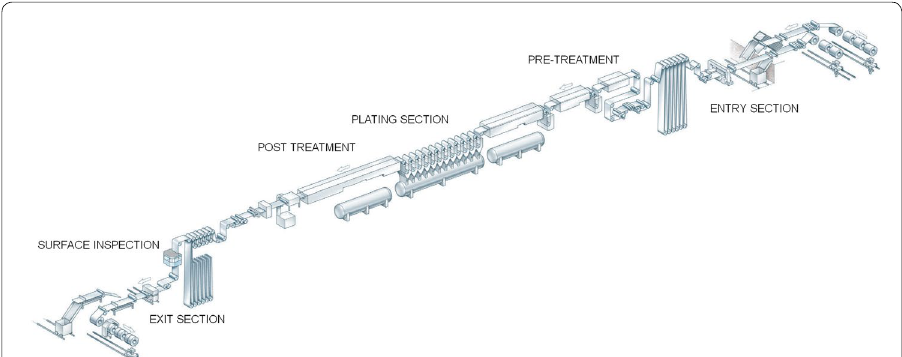
Fig. 1 Schematic drawing of the electro galvanizing line. In the entry section, the strip is decoiled and welded to the previous strip. After alkaline cleaning and acidic pickling, the strip enters the plating section consisting of twelve GRAVITEL ® - cells. After rinsing and optional post treatment, the strip is inspected and cut into coils